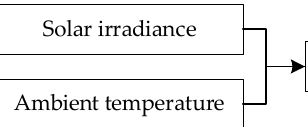
Figure 8. Basic operation model of wind generation.